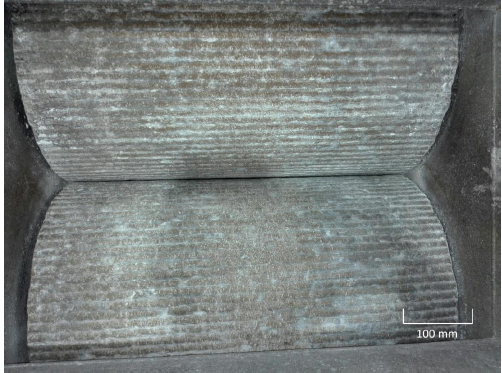
Figure 5. Inside view of the fluted roll crusher.